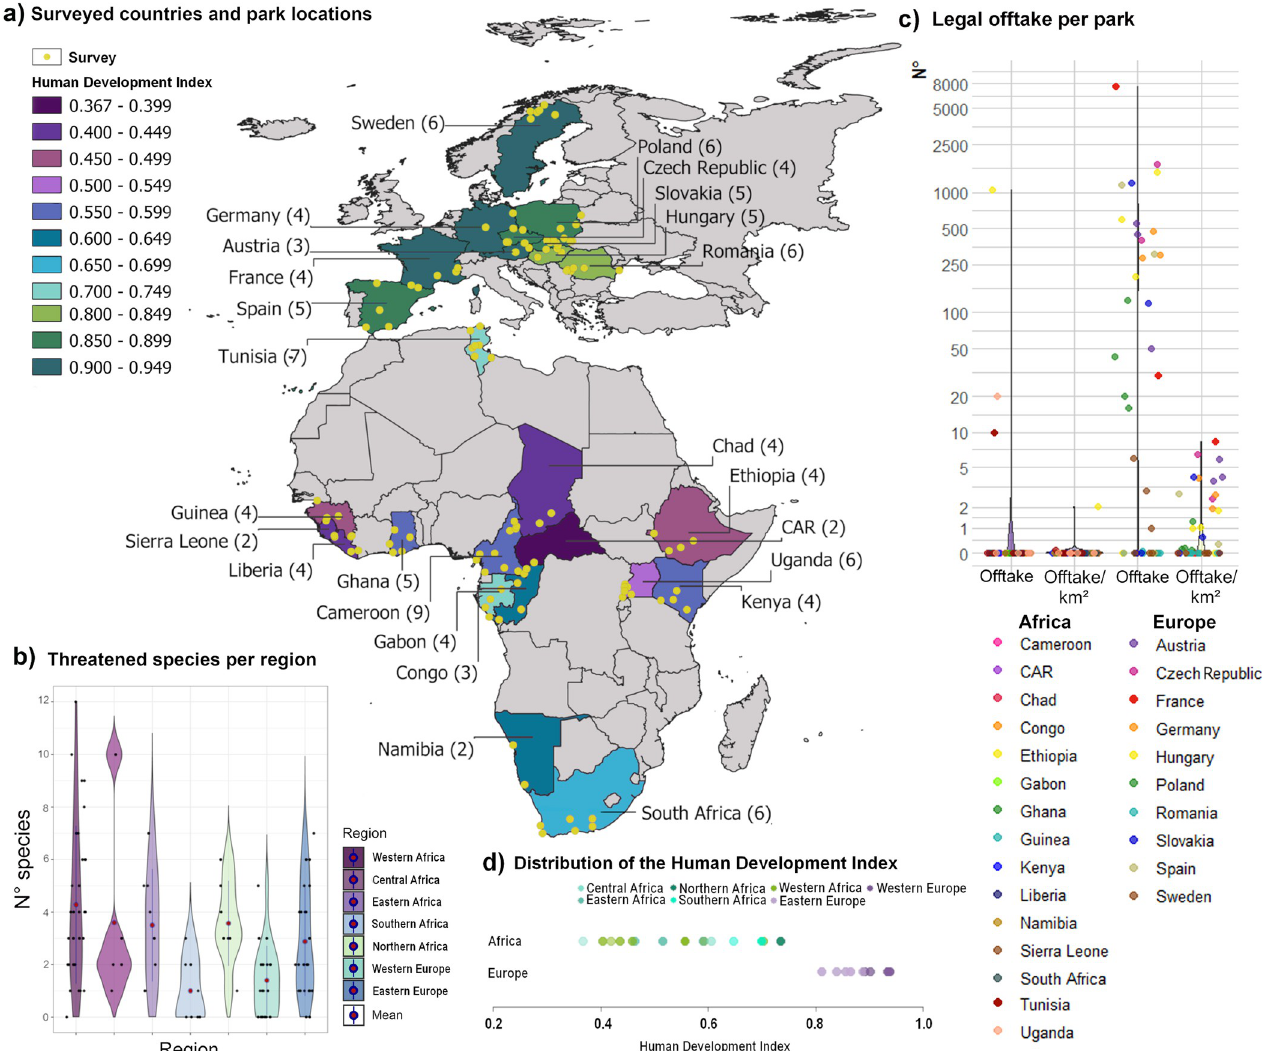
Fig 1. Overview of sample locations, legal setting, and threatened species. a) Map of sampled PAs (yellow dots) and HDI per surveyed country. The Global South-North divide in our data is > 0.75, defined as the so-called Global North (Europe, green), and < 0.75, defined as the Global South (Africa, purple–blue) (the data underlying this figure can be found in S1 Data) (source: https://public.opendatasoft.com/explore/dataset/world-administrative-boundaries/export/). (b) Violin plots displaying the absolute number of species threatened by hunting listed by PAs across regions, black dots = number of listed threatened species per park, blue and red dots = mean per region, blue line = interquartile range, each side of the blue line is a kernel density estimation of the data (S2 Data). (c) Legal offtake per PA in absolute numbers (left) and numbers per km 2 per continent (right) (Table U in S1 Appendix and S3 Data). (d) Distribution of the HDI along the surveyed regions. The distribution shows the socioeconomic gradient covered by our survey along the Global South-North, or respectively, the Africa-Europe South-North gradient (S-N gradient) (S1 Data). HDI AU : AbbreviationlistshavebeencompiledforthoseusedinFigs 1 (cid:0) 4 : Pleaseverifythatallentriesarecorrect : , Human Development Index; PA, protected area.